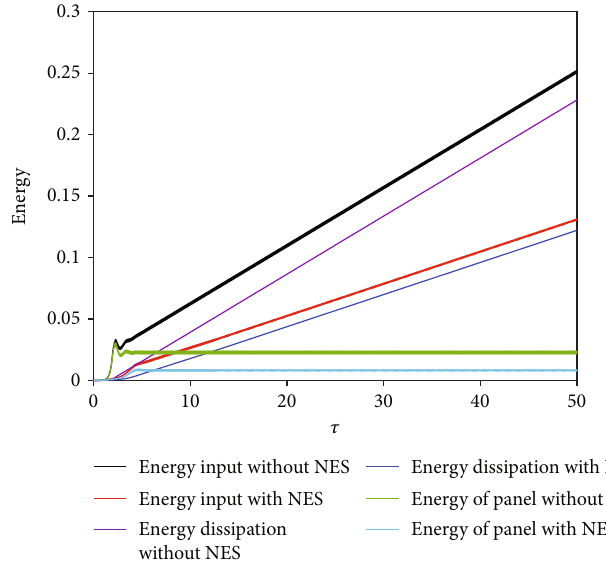
Figure 12: Time history of vibration energy.